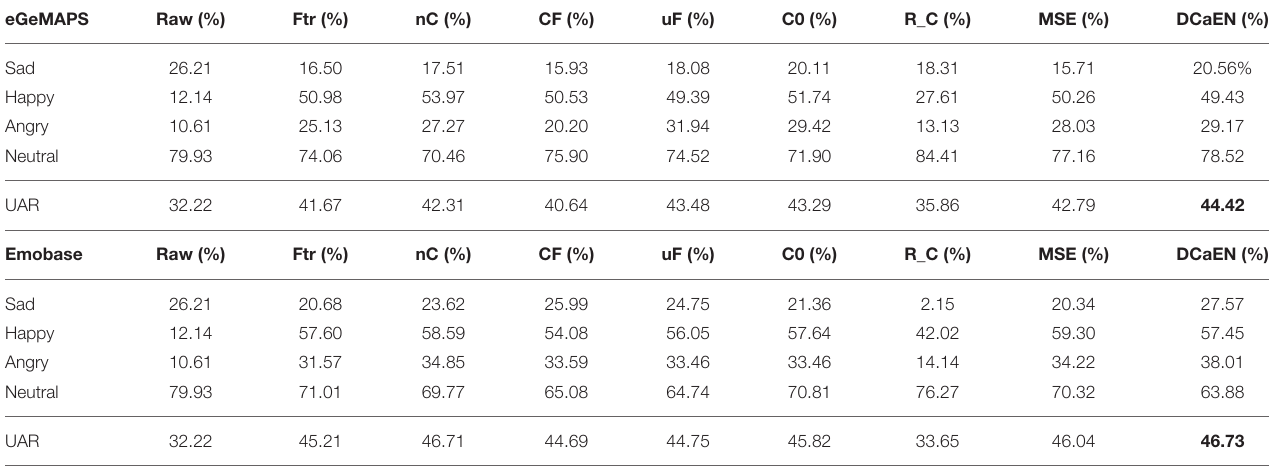
TABLE 3 | Comparing performances of emotion recognition for different models on the MSP-IMPROV.